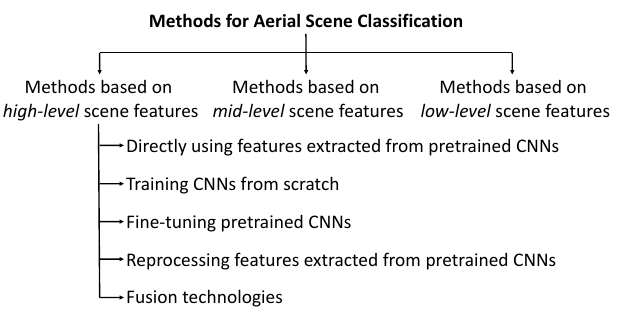
Figure 1. A categorization of the methods for aerial scene